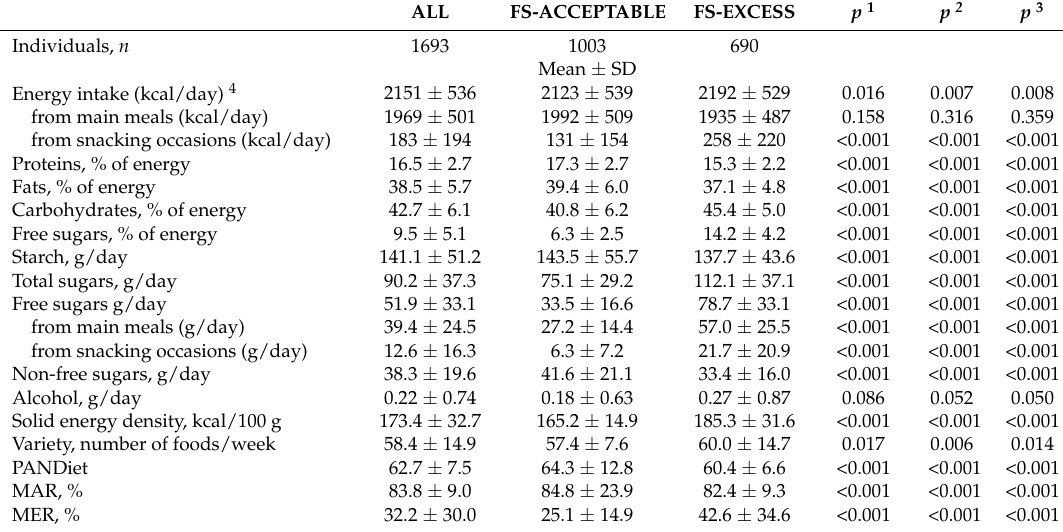
Table 2. Observed nutritional intakes and diet quality indicators for the total sample and for FS-ACCEPTABLE and FS-EXCESS groups (mean ±